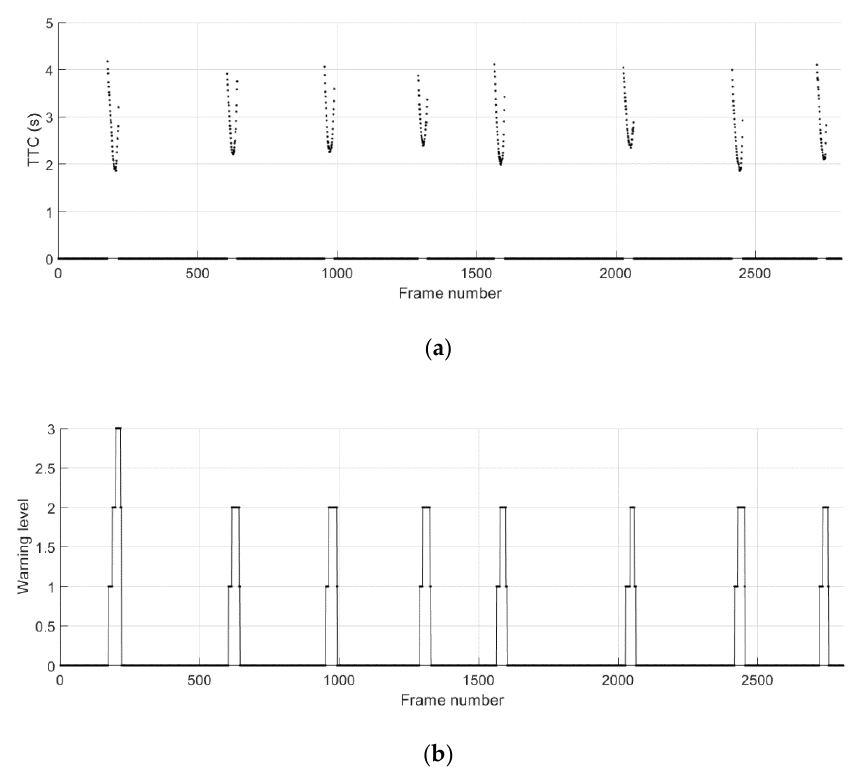
Figure 18. Potential crash events predicted during the cut-in driving scenario 3. ( a ) Time-to-collision (TTC); ( b ) collision warning level.